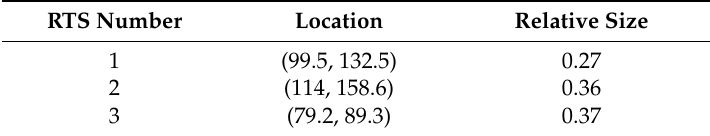
Table 2. Location and relative size for the optimal three RTSs.